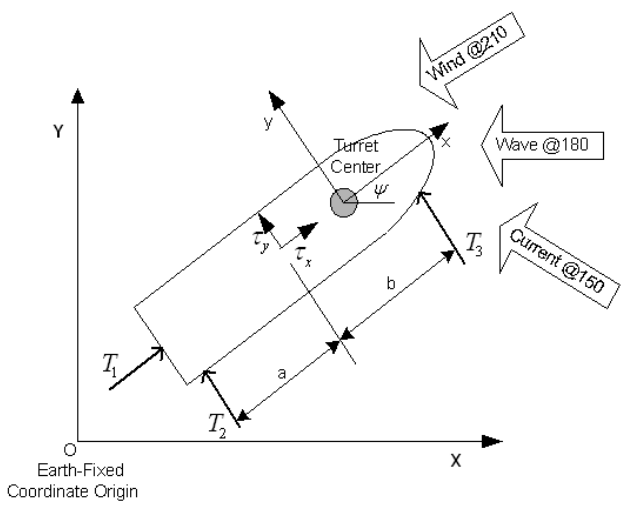
Figure 9. Coordinate System and Environmental Forces.